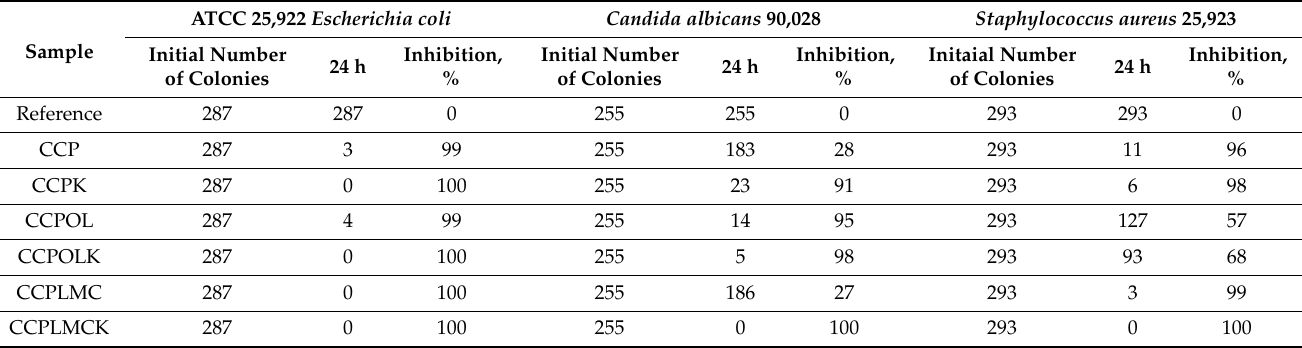
Table 5. Antimicrobial activity for tested